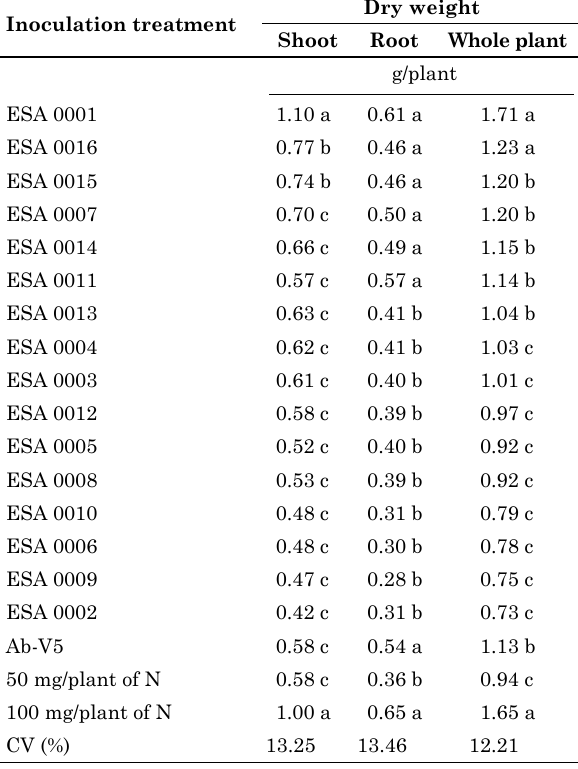
Table 4. Growth of ‘bRs Tropical’ rice ( Oryza sativa ) plants as a result of inoculation of plant growth promoting bacteria isolated from Tripogon spicatus . Data are means of four